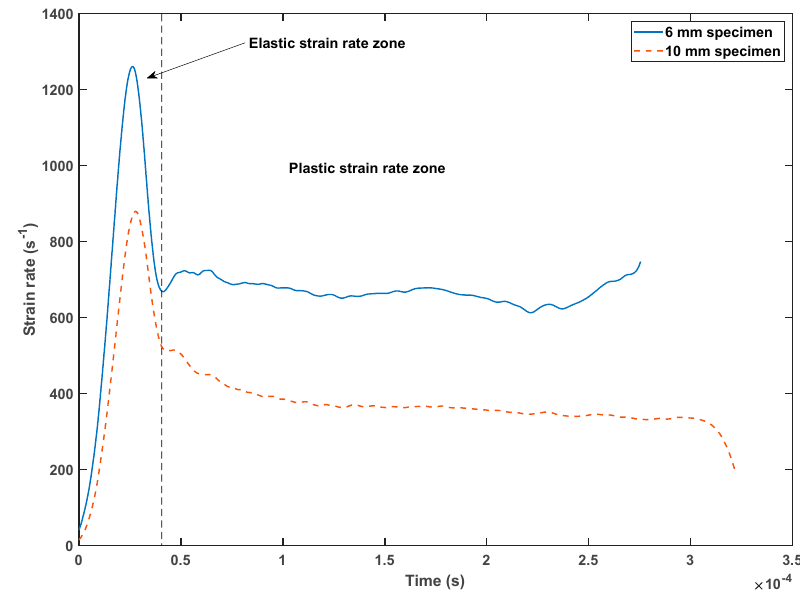
Figure 5. Typical imposed strain rate vs. time history for the 6 mm and 10 mm AB specimens.